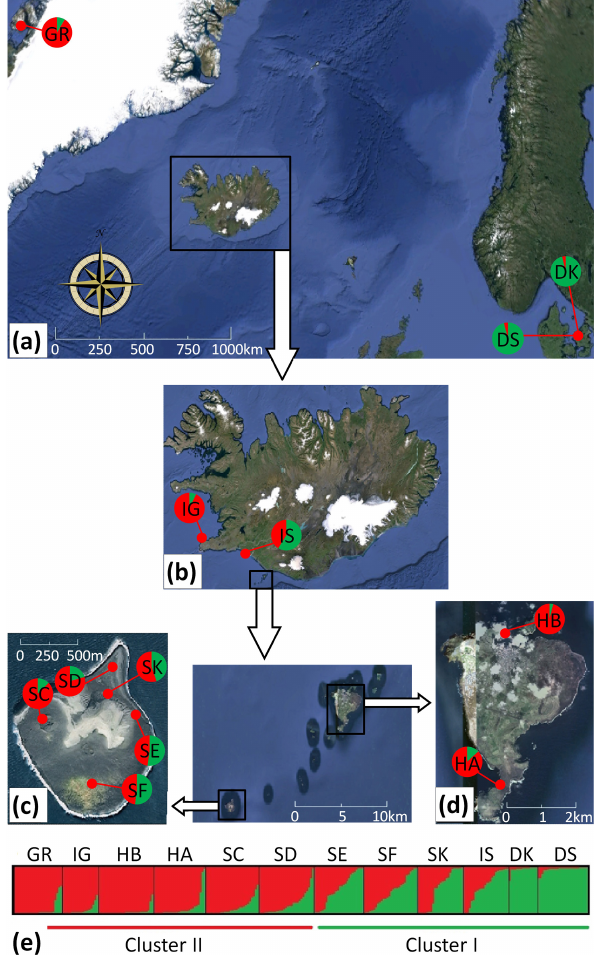
Figure 1. Bayesian inference clustering based on AFLP results us- ing the admixture ancestral model in STRUCTURE software. For the full AFLP data set, the model K = 2 produced the highest (cid:49)K value, hence two groups assigned in red versus green. The two ge- netic groups detected are represented as pie charts on the Google Earth maps of the following: (a) all sampling locations, (b) Iceland, (c) Surtsey and (d) Heimaey. An alignment based on proportion be- tween the two genetic groups in each population (e) reveals two clusters, I and II, whereby Denmark populations (DK & DS) pre- dominate Cluster-I (green) and Greenland (GR) at the opposite end in Cluster-II (red). Population names are abbreviated as in Table